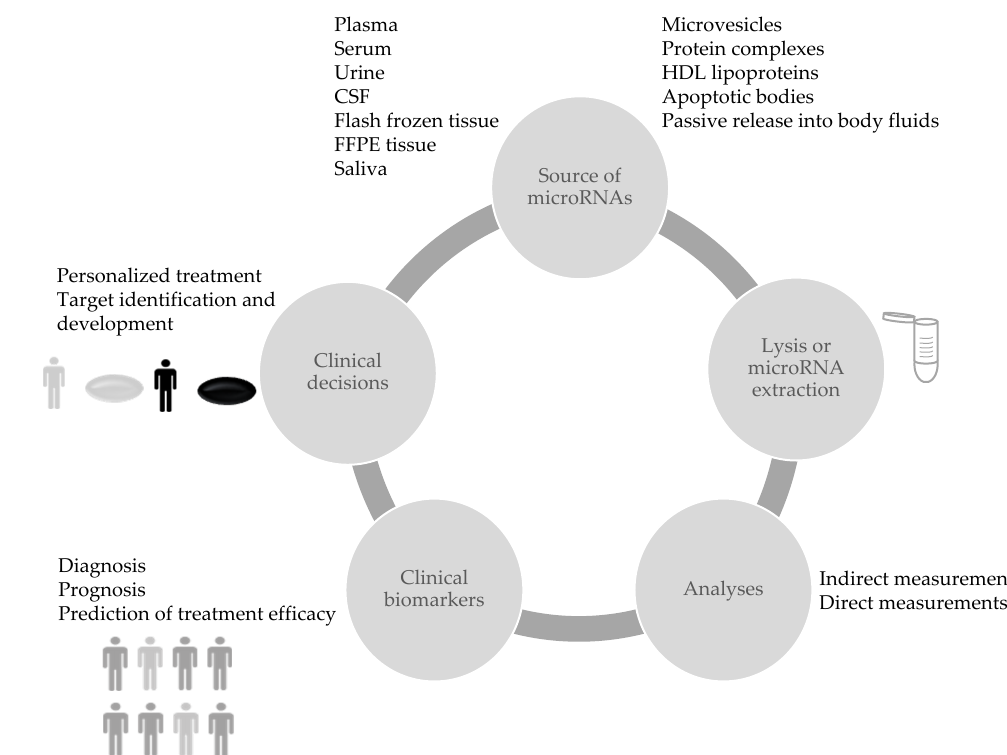
Figure 1. miRNAs are involved in all cellular processes and dysregulated in disease, potentially representing optimal biomarkers. They can be purified from different tissues or liquid biopsies and then measured with the different technologies described in the text. Differential expression of miRNAs may indicate an increased risk of disease or have a diagnostic or prognostic value, leading to clinical